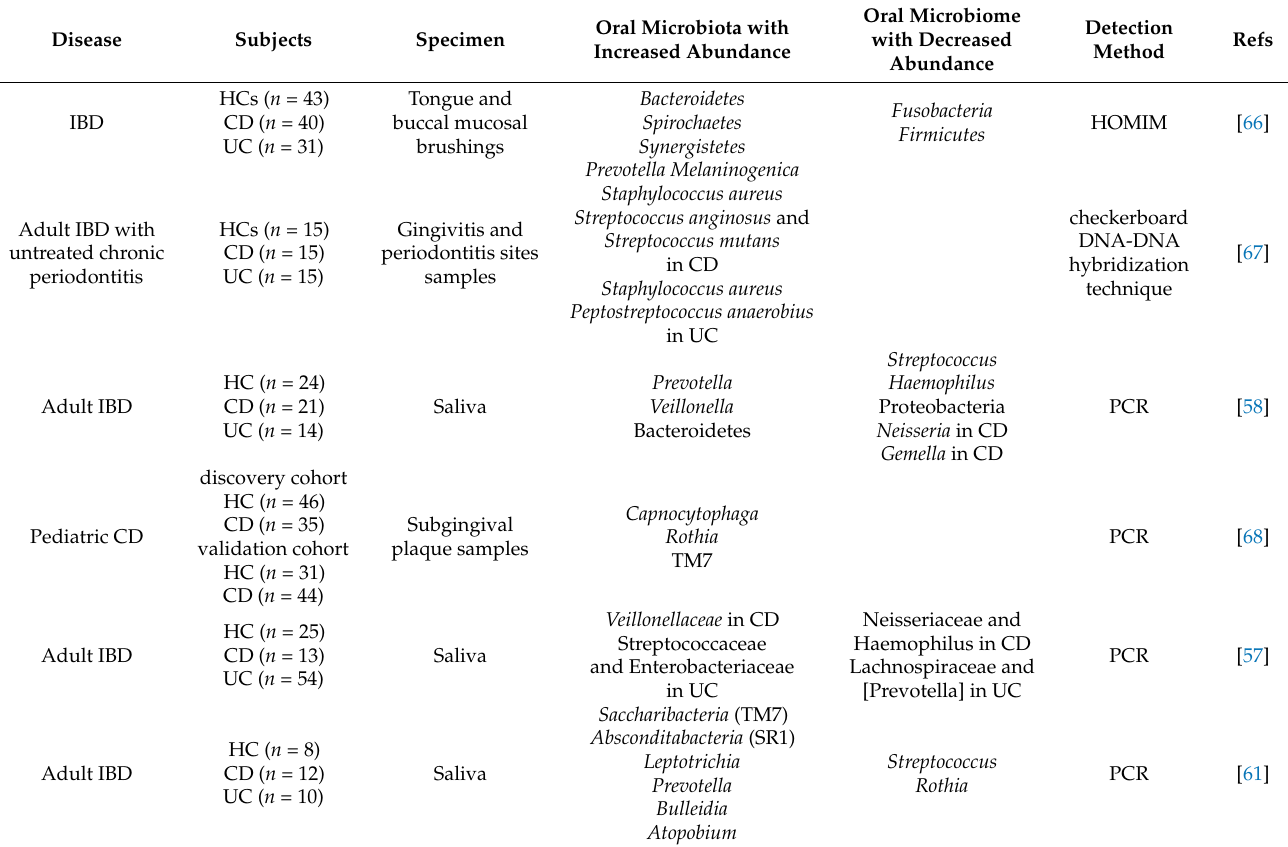
Table 1. Oral microbiota changes in inflammatory bowel